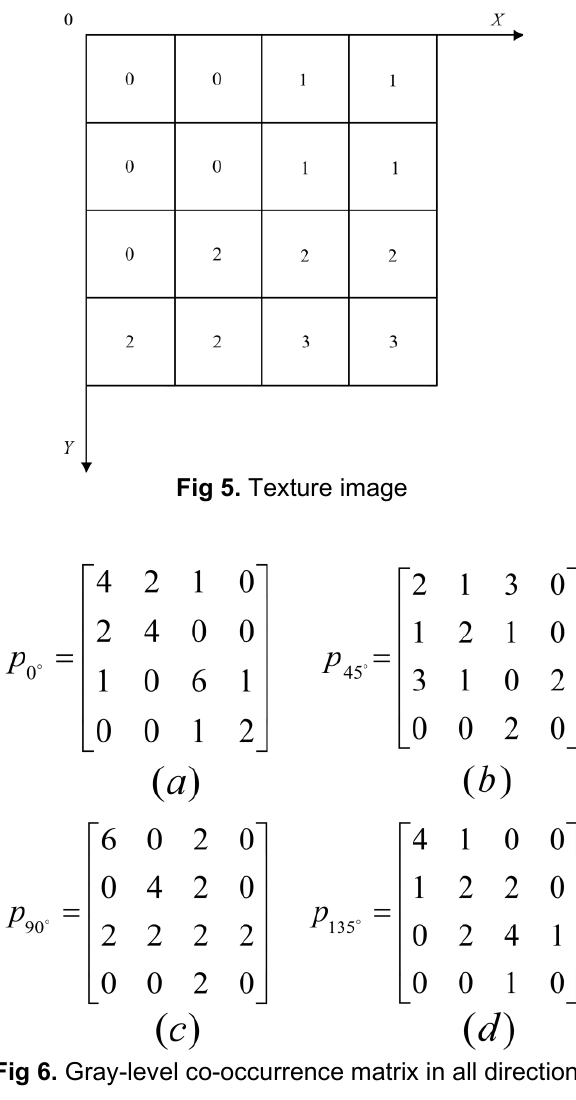
Fig 6. Gray-level co-occurrence matrix in all directions